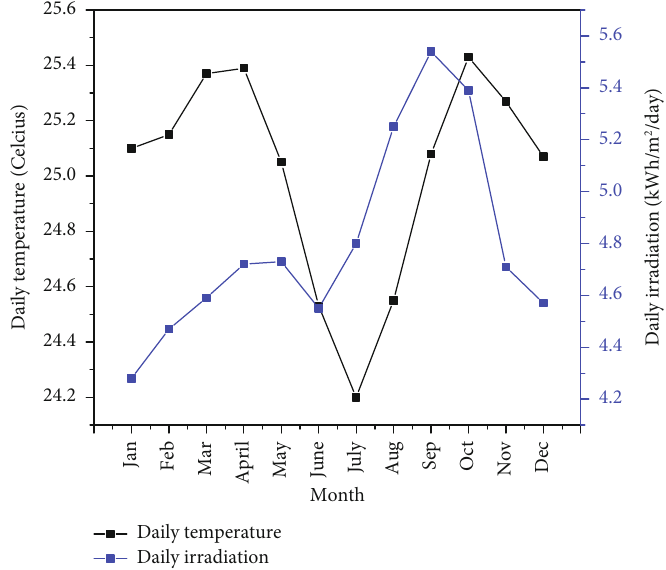
Figure 3: Daily irradiation and temperature in the project